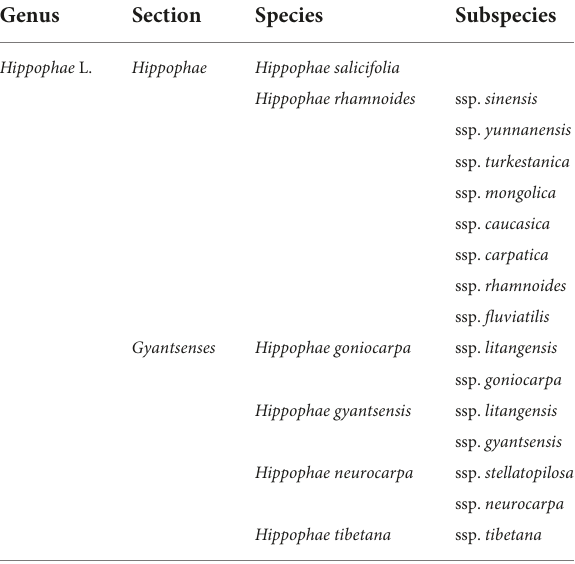
TABLE 1 Classification of Hippophae